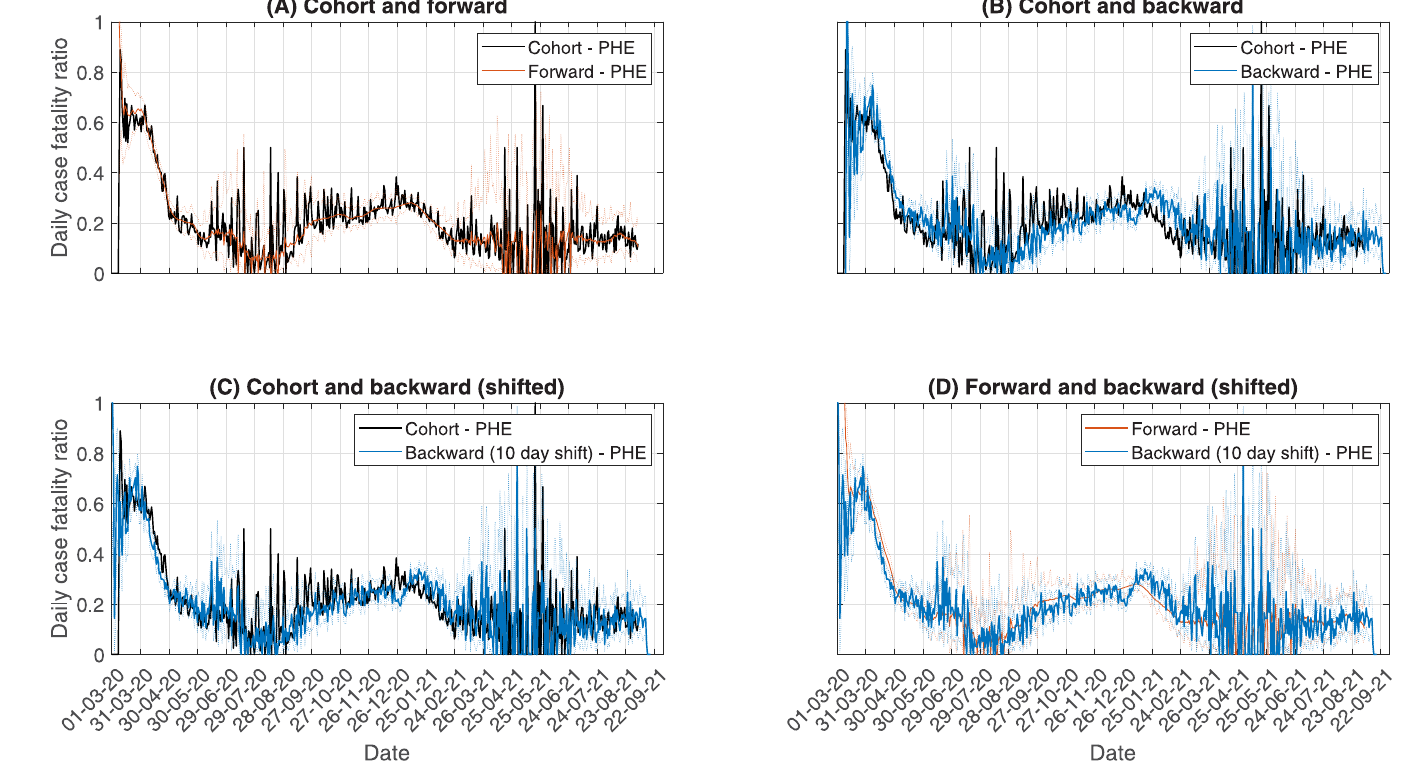
Fig 2. Comparing the methods. Top left: cohort versus forward. Top right: cohort versus backward. Bottom left: Cohort versus shifted backward. Bottom right: Forward versus shifted backward. Dashed lines indicate the 95% confidence intervals of the daily CFR estimates. In the shifted backward results, we shift the daily estimates to 10 days prior, reflecting the average delay from testing positive to